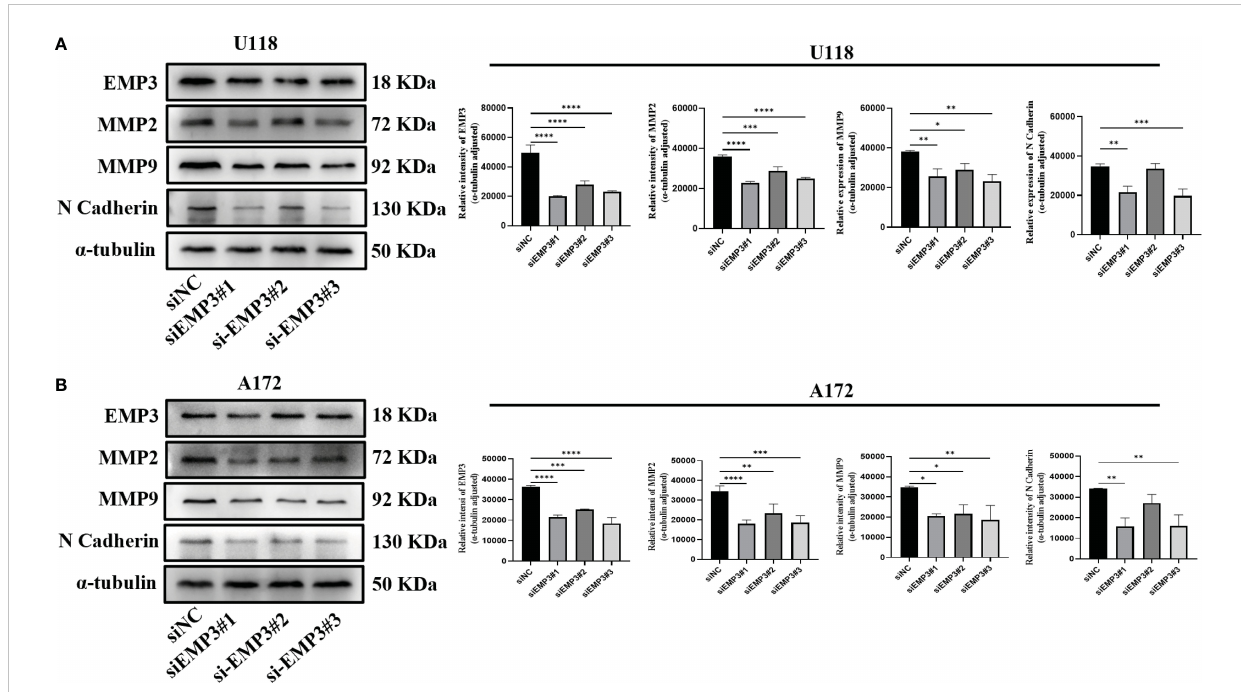
FIGURE 10 EMP3 silencing suppressed EMT marker expression. (A) Western blot analysis of U118 transfected with indicated siRNAs targeting EMP3 (siEMP3#1, siEMP3#2, and siEMP3#3) or siNC. (B) Western blot analysis of A172 transfected with indicated siRNAs targeting EMP3 (siEMP3#1, siEMP3#2, and siEMP3#3) or siNC. (p > 0.05; *p < 0.05; **p < 0.01; ***p < 0.001; ****p <